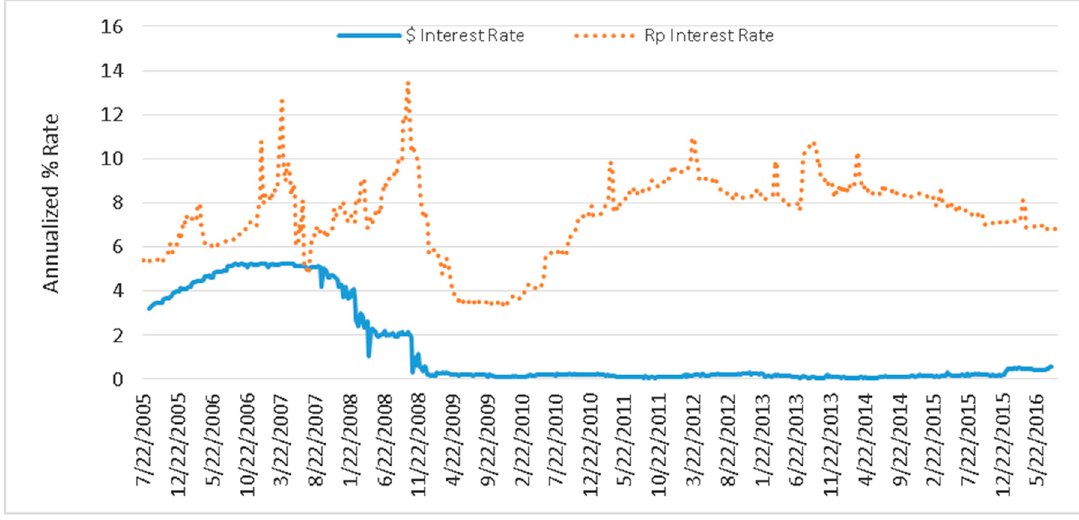
Figure 2. US $ denominated vs. Indian Rp denominated Interest Rates.